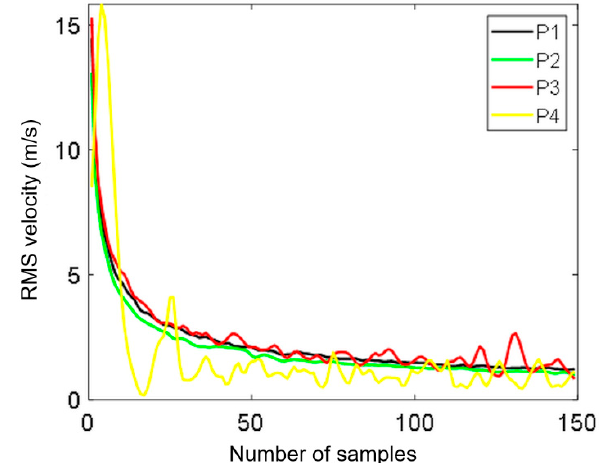
Figure 10. Convergence for the RMS velocity at the control points.